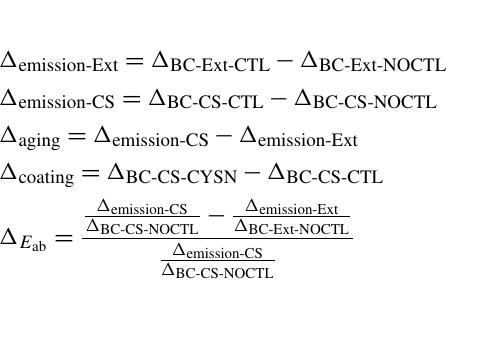
Figure 1. Scatter plots of modeled and observed near-surface meteorological variables ( a : T , b : RH, c : wind speed); modeled AAOD with the core-shell model and an external mixing assumption, and the comparisons against observations (d) ; modeled and observed AOD (e) .